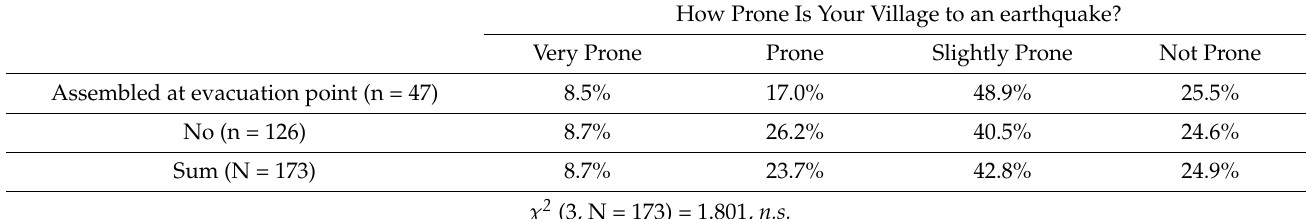
Table 5. Relationship between perceived earthquake risk and people’s response. How Prone Is Your Village to an